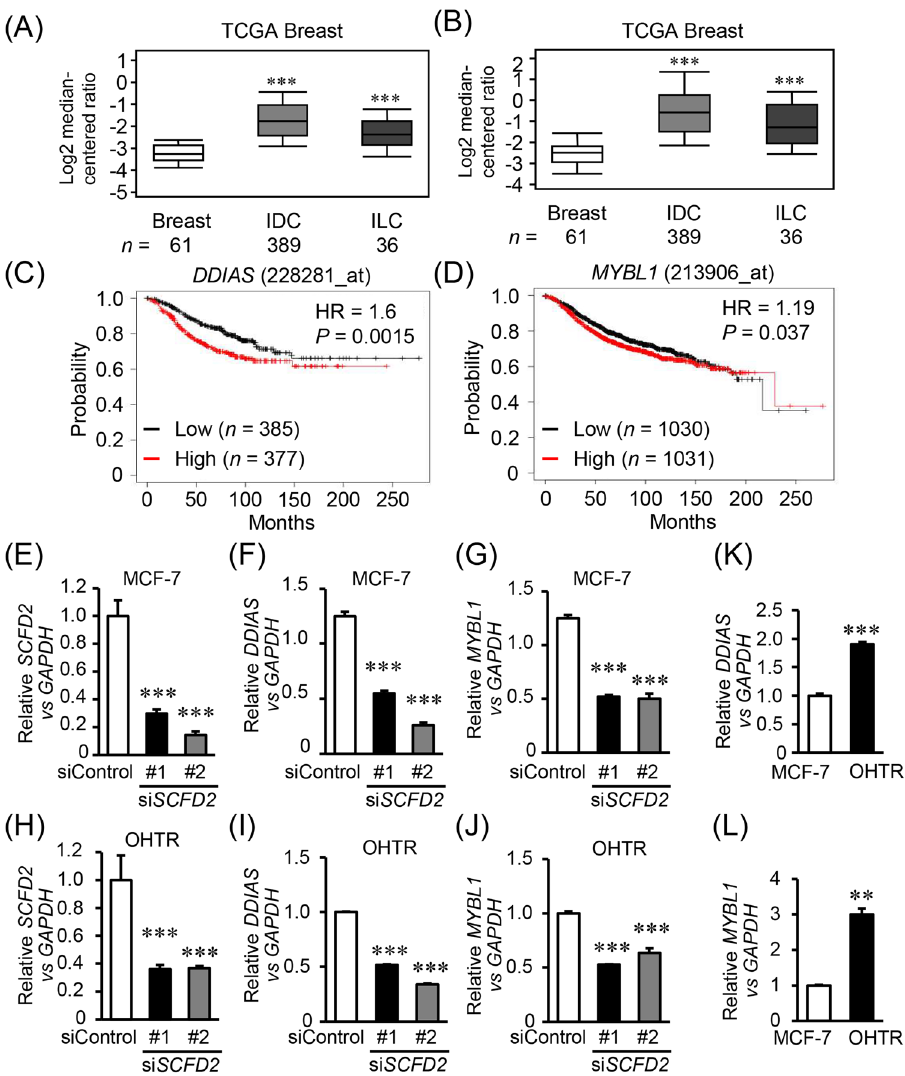
Figure 4. DDIAS and MYBL1 are SCFD2 downstream target genes and associated with worse prognosis in ER-positive breast cancer. ( A , B ) DDIAS ( A ) and MYBL1 ( B ) mRNA expression in normal breast tissues (Breast), invasive ductal breast carcinoma (IDC), and invasive lobular breast carcinoma (ILC) based on TCGA breast cancer dataset retrieved from the Oncomine™ Platform (www. oncom ine. org). ( C , D ) Relapse-free survival of ER-positive breast cancer patients with high or low mRNA expression of DDIAS ( C ) or MYBL1 ( D ) analyzed by online Kaplan–Meier plotter (http:// kmplot. com/). ( E – J ) SCFD2 ( E , H ), DDIAS ( F , I ), and MYBL1 ( G , J ) mRNA levels in MCF-7 and OHTR cells transfected with control (siControl) or SCFD2-specific (si SCFD2 #1 and #2) siRNAs (10 nM) were analyzed by qRT-PCR. Relative expression levels of these mRNAs were normalized to GAPDH mRNA level in each sample and presented as mean fold ± SEM compared with siControl ( n = 3). ( K , L ) Relative expression levels of DDIAS ( K ) and MYBL1 ( L ) mRNAs in MCF-7 and OHTR cells were normalized to GAPDH mRNA level in each sample and presented as mean fold ± SEM compared with siControl ( n = 3). ** P < 0.01; *** P < 0.001, two-way ANOVA performed in Fig. 5E–J. ** P < 0.01; *** P < 0.001, Student’s t -test performed in Fig. 5K,L